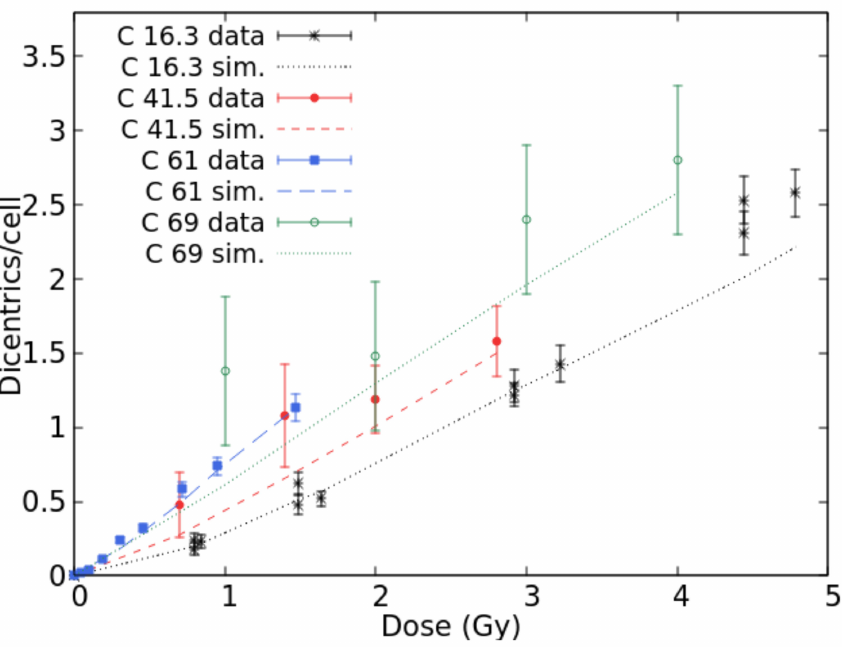
Figure 3. Mean number of dicentrics per cell versus dose for C-ion beams with LET values of 16.3, 41.5, 61.0, and 69.0 keV/ µ m. The points with error bars are experimental data, and the lines are simulation